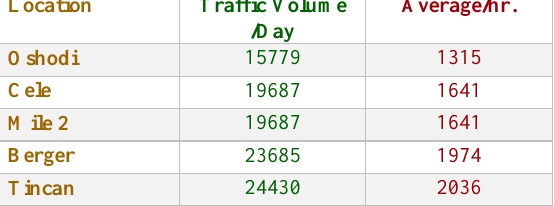
Table 1: Notable congestion